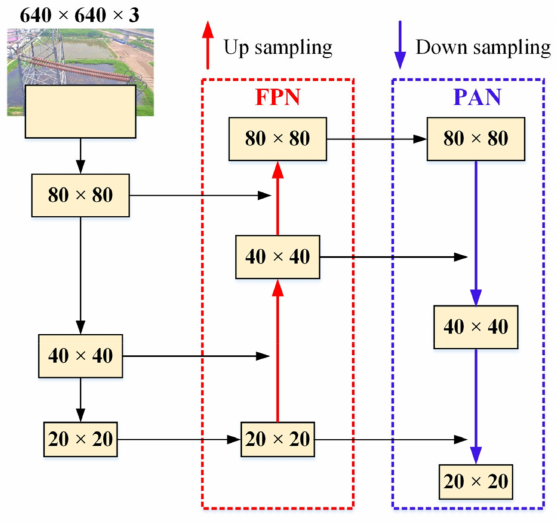
Figure A4. The enhanced feature extraction module fixed by FPN and